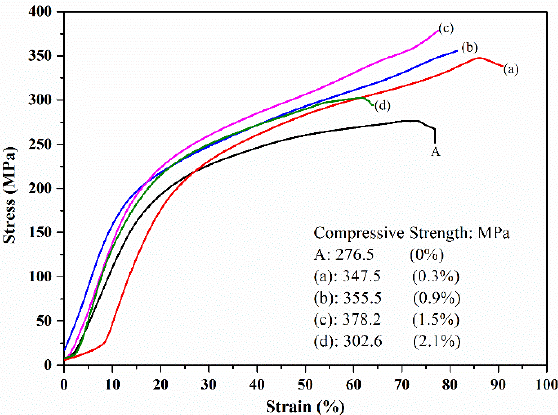
Figure 6. Compression strength of the strain-stress curve of the samples: (A) is the blank samples; and (a)–(d) are the 0.3–2.1% resin-added samples.